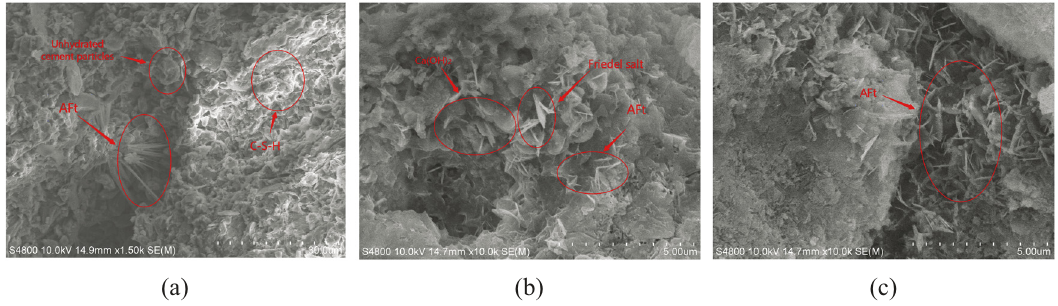
Figure 3: Microscopic morphology of concrete after freeze – thaw cycles: ( a ) 0 freeze – thaw cycles, ( b ) 200 freeze – thaw cycles in the chlorine solution, and ( c ) 200 freeze – thaw cycles in the sulfate